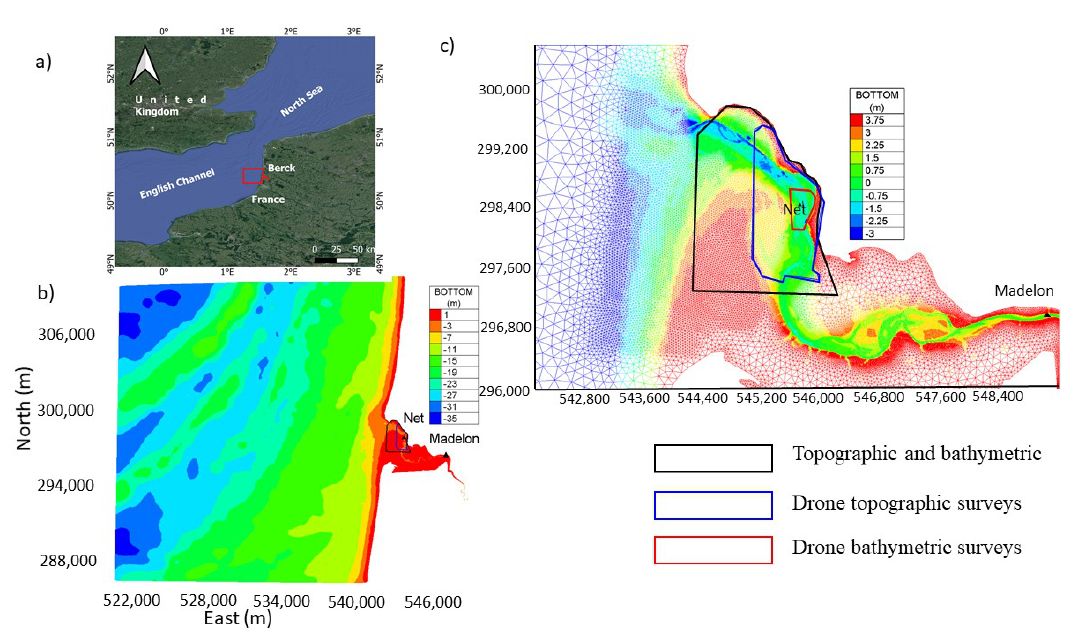
Figure 1. Location of Authie estuary and survey stations ( a ); model domain in numerical model ( b ); and areas of topographic and bathymetric surveys ( c